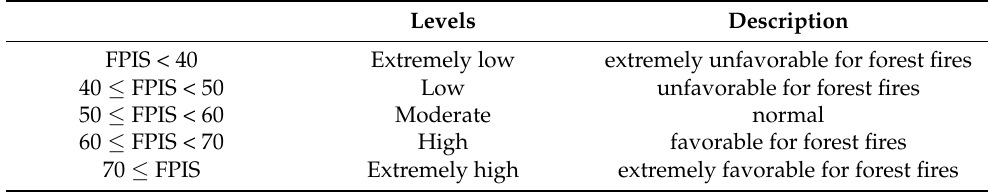
Table 3. Forest fire risk level based on FPIS